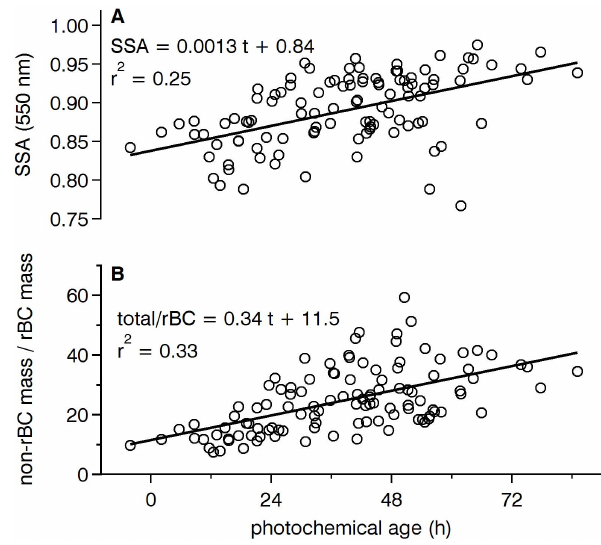
Fig. 9. Campaign-averaged ratios of humidified-to-dry corrected light scattering coefficients for 550nm as a function of relative humidity during the EM25 (London, black) and VOCALS (south- eastern Pacific, red)